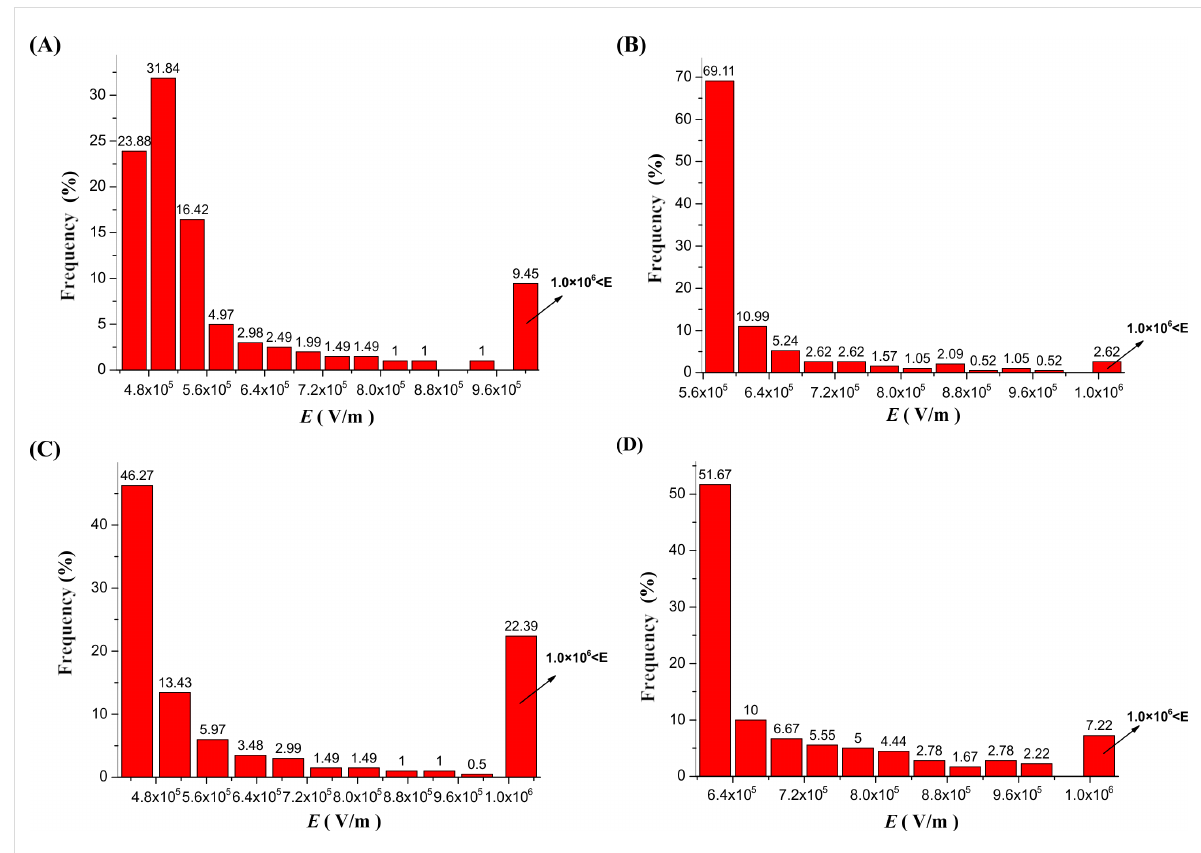
the top edge of the reservoir. The calculated values of E max , E av and ƒ are are given in Table 3. Comparing the four devices, Figure 9 reveals that the radial distributions of the electric field are quite different. To compare this difference in more detail, Table 3 gives a detailed overview of the intensity distribution of electric field ( E R ) along the radial axis (0–20 mm) of the four self-made FSE